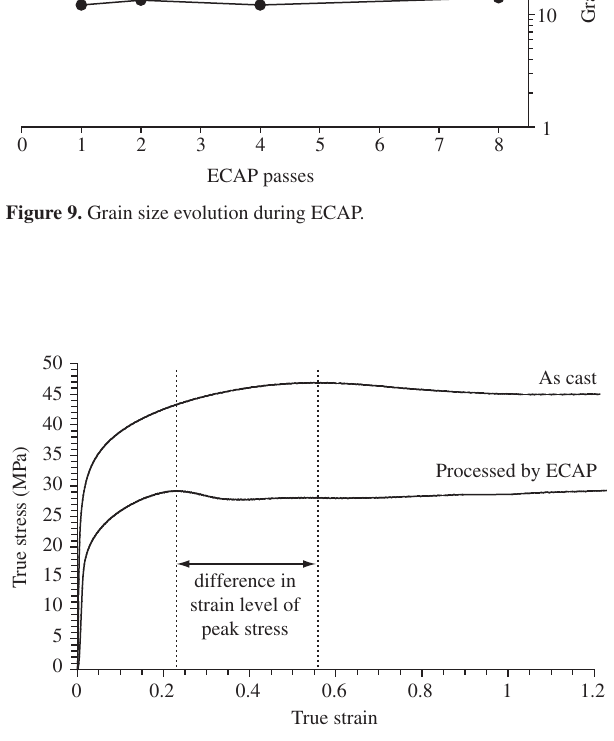
Figure 10. Flow curve of the material in the as cast state and after 1 pass of ECAP, determined by compression